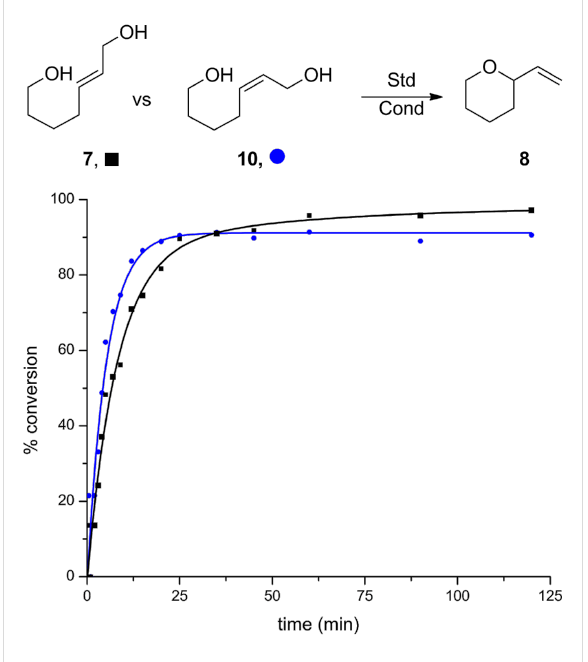
Figure 3: Reaction progress in cis - and trans -diols. Conditions: 5 mol % Au[P( t -Bu) 2 ( o -biphenyl)]SbF 6 , CH 2 Cl 2 , MS 4